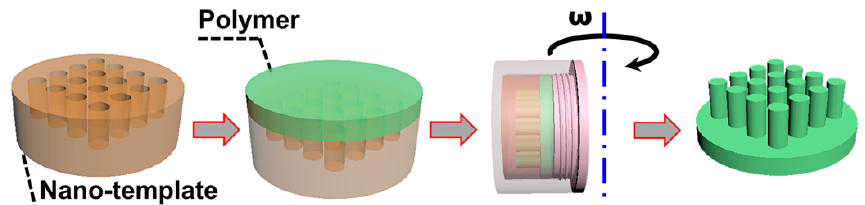
Figure 1. Schematic illustration of the processes of nano-replication.